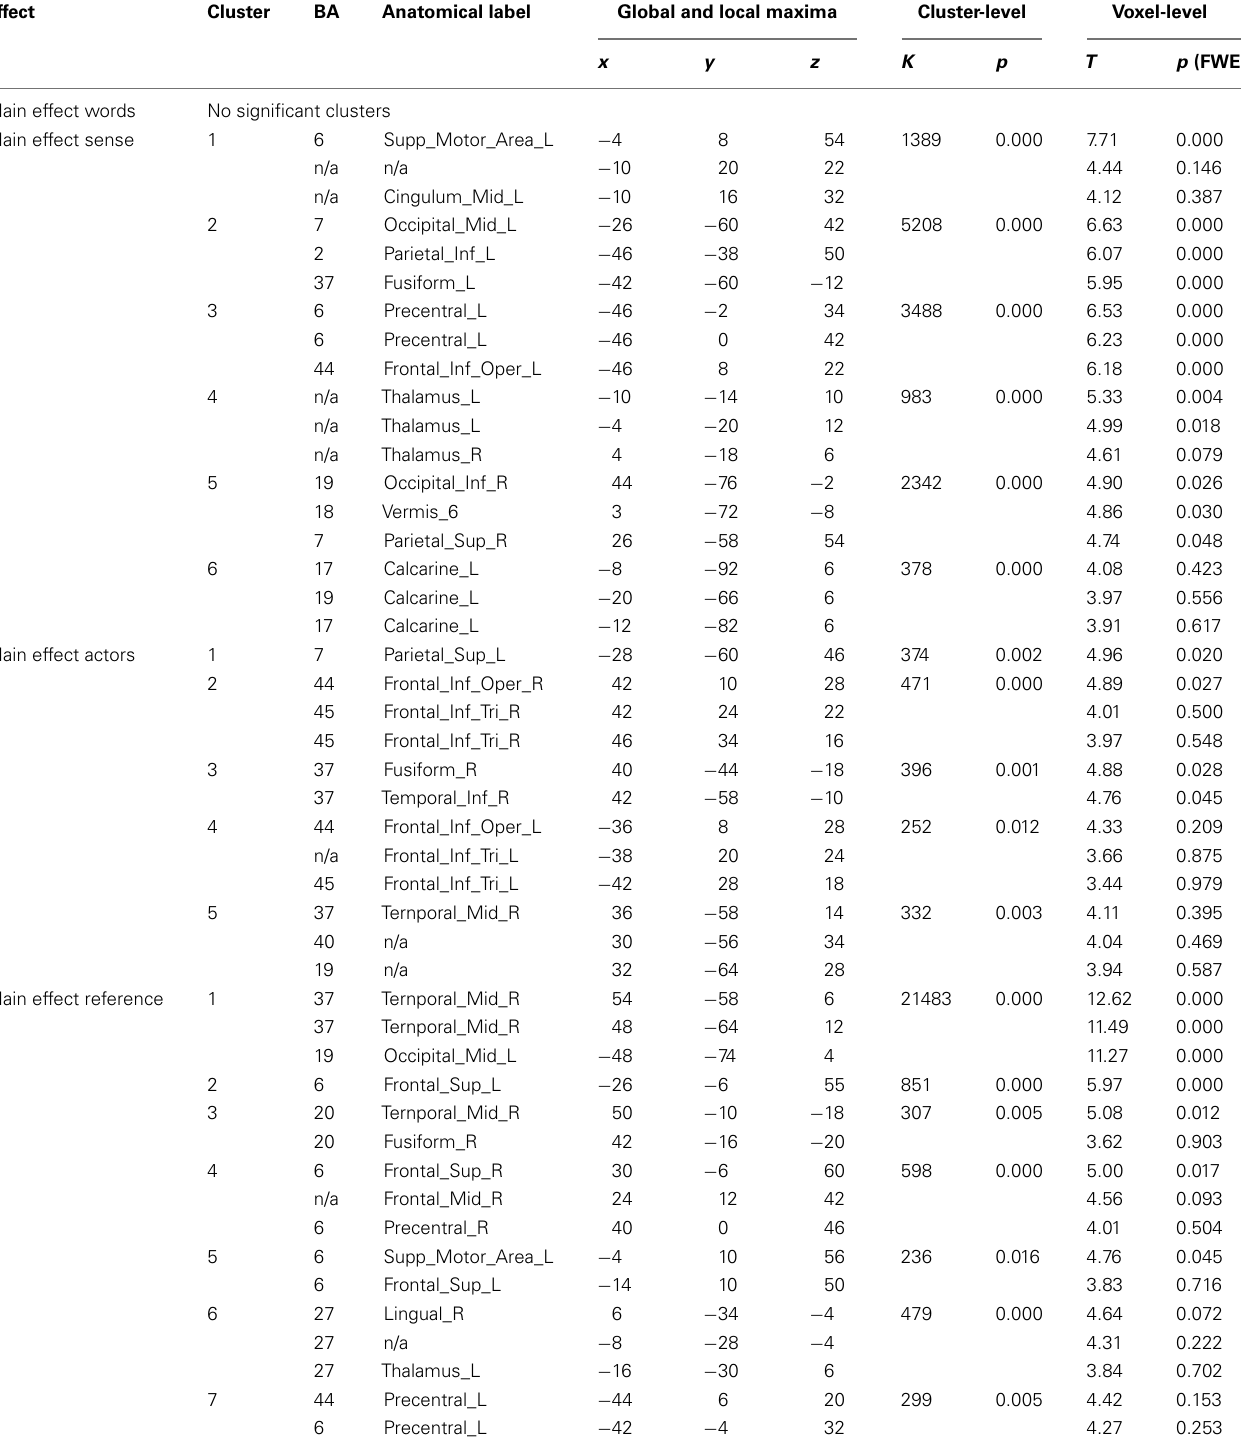
Table 2 | Main effects for all factors in the